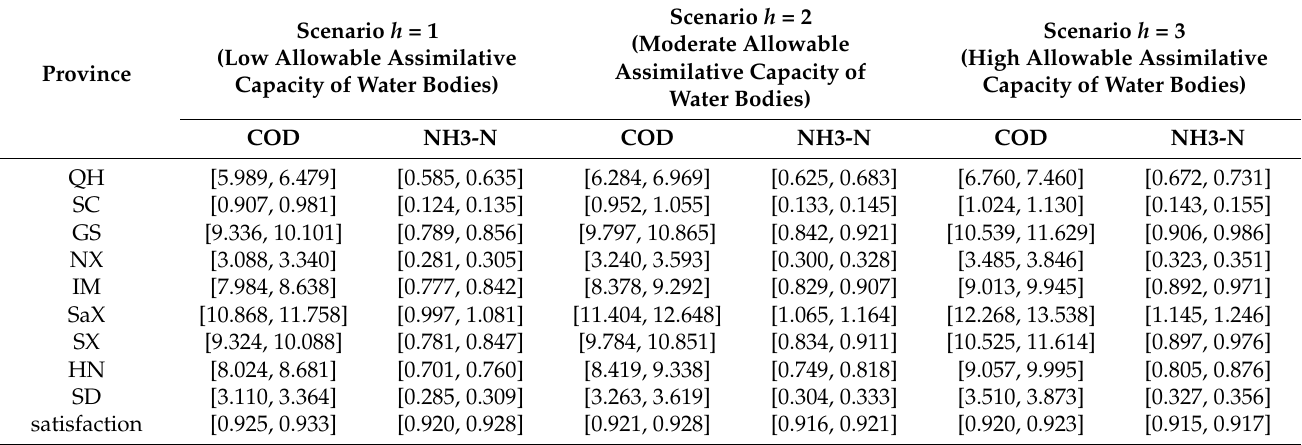
Table 3. Initial emission rights allocation results in the Yellow River Basin under total amount control. (Unit: 100,000